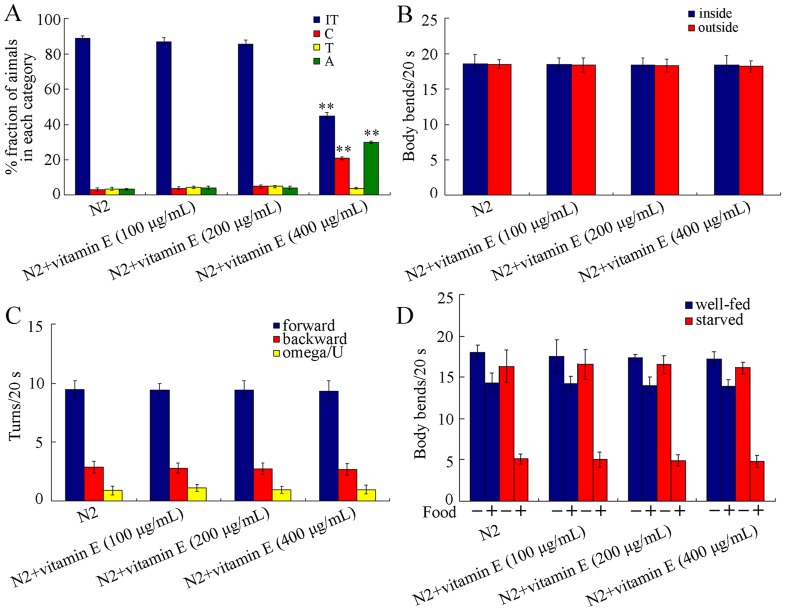
Effects of vitamin E treatment at different concentrations on thermotaxis and locomotion behaviors in C. elegans.(A) Effects of vitamin E treatment at different concentrations on thermotaxis behavior. In the thermotaxis assay system, movement to 25°C was scored as thermophilic (T); movement to 17°C was scored as cryophilic (C); movement across the thermal gradient (17°C/25°C) was scored as athermotactic (A); movement at 20°C was scored as isothermal tracking behavior (IT). (B) Effects of vitamin E treatment at different concentrations on body bends of nematodes inside and outside learning assay model. (C) Effects of vitamin E treatment at different concentrations on basic movements of the examined nematodes. (D) Effects of vitamin E treatment at different concentrations on basal and enhanced slowing responses of the examined nematodes. Data are expressed as mean ± SEM. **p<0.01 vs. N2.